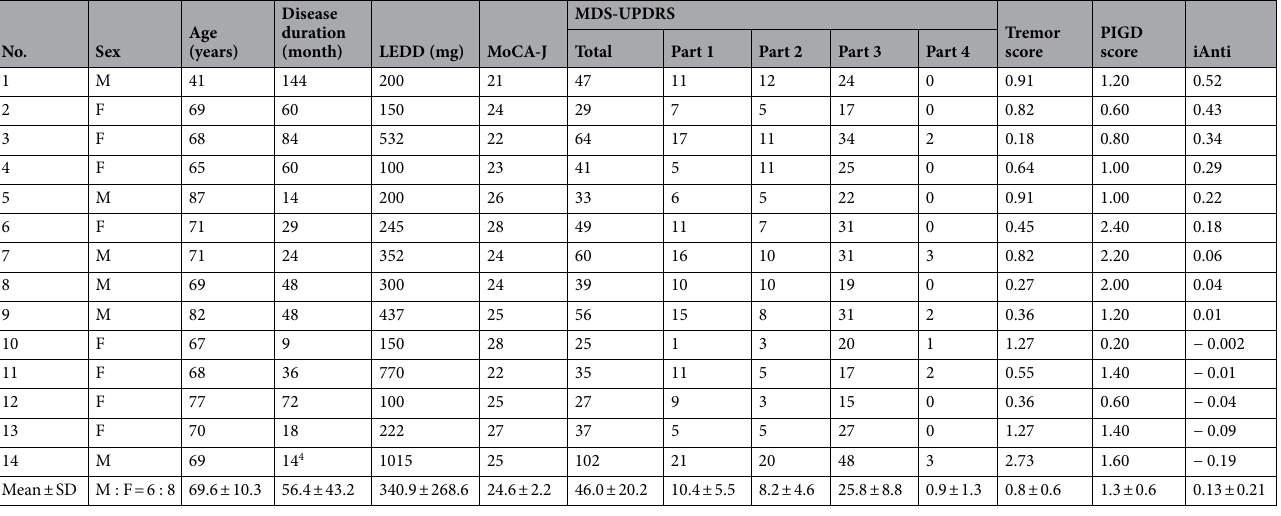
Table 1. Demographics and clinical measures. LEDD levodopa equivalent daily dose, MoCA-J Japanese version of the Montreal Cognitive Assessment, MDS-UPDRS Movement Disorder Society-Sponsored